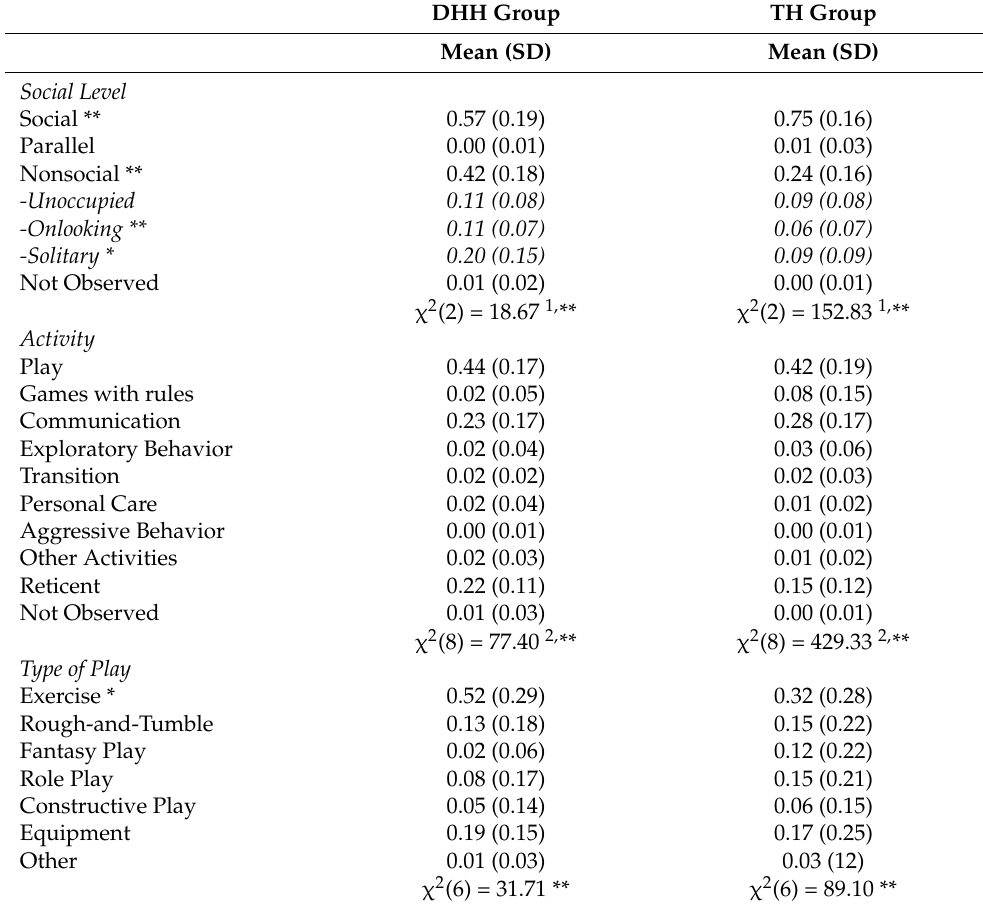
Table 1. Mean scores (SD), mean rank and results of Friedman’s Rank Text for children’s engagement in different social levels, activity, and types of play by group.